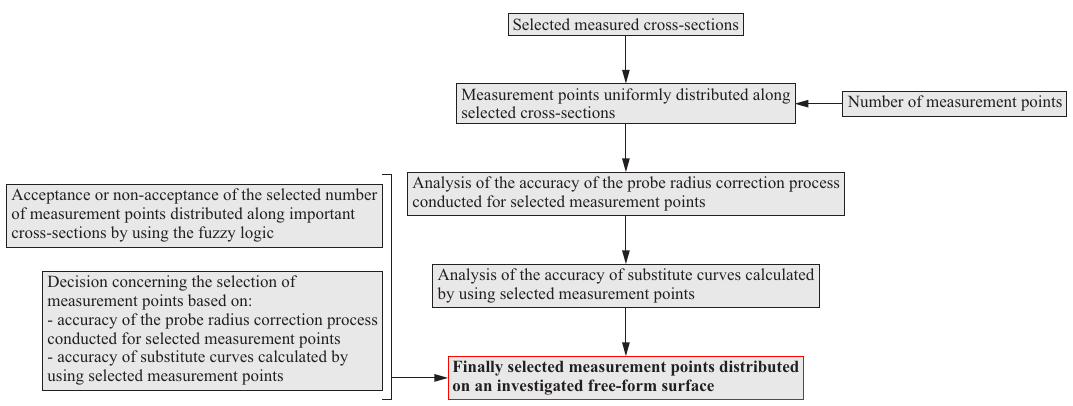
Figure 4. Algorithm of the distribution of measurement points along selected scanning